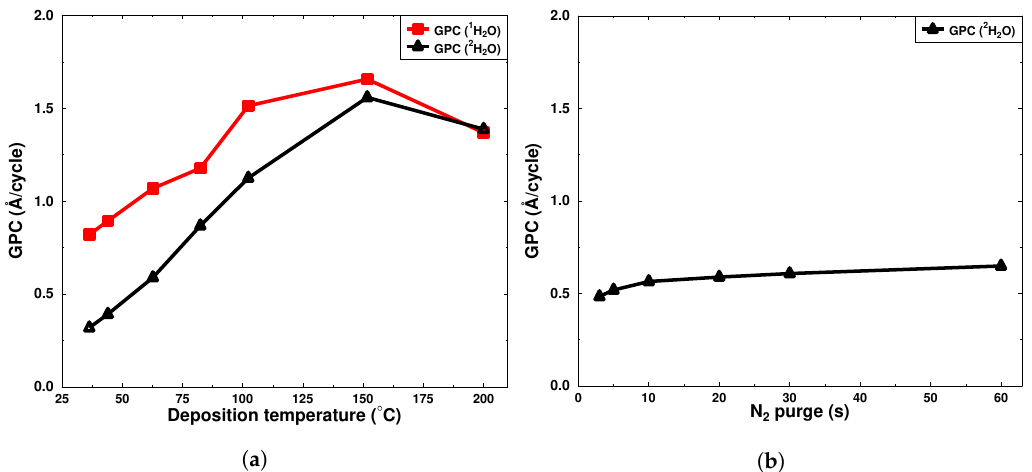
Figure 1. ( a ) Growth-per-cycle as a function of the deposition temperature. One ALD cycle consisted of a 150 ms DEZ pulse, 10 s purge, 500 ms 1 H 2 O/ 2 H 2 O pulse and 20 s purge. ( b ) Growth-per-cycle as a function of the purging time using DEZ and 2 H 2 O as precursors at 60 ◦ C. The purging times after both precursors were kept the same when the purging time was 3, 5 or 10 s. For the longer purging times, only the purge after 2 H 2 O was increased, and the purge after DEZ was kept at 10 s. Table 1. The main results of ZnO samples deposited with both 1 H 2 O and 2 H 2 O at different deposition temperatures.